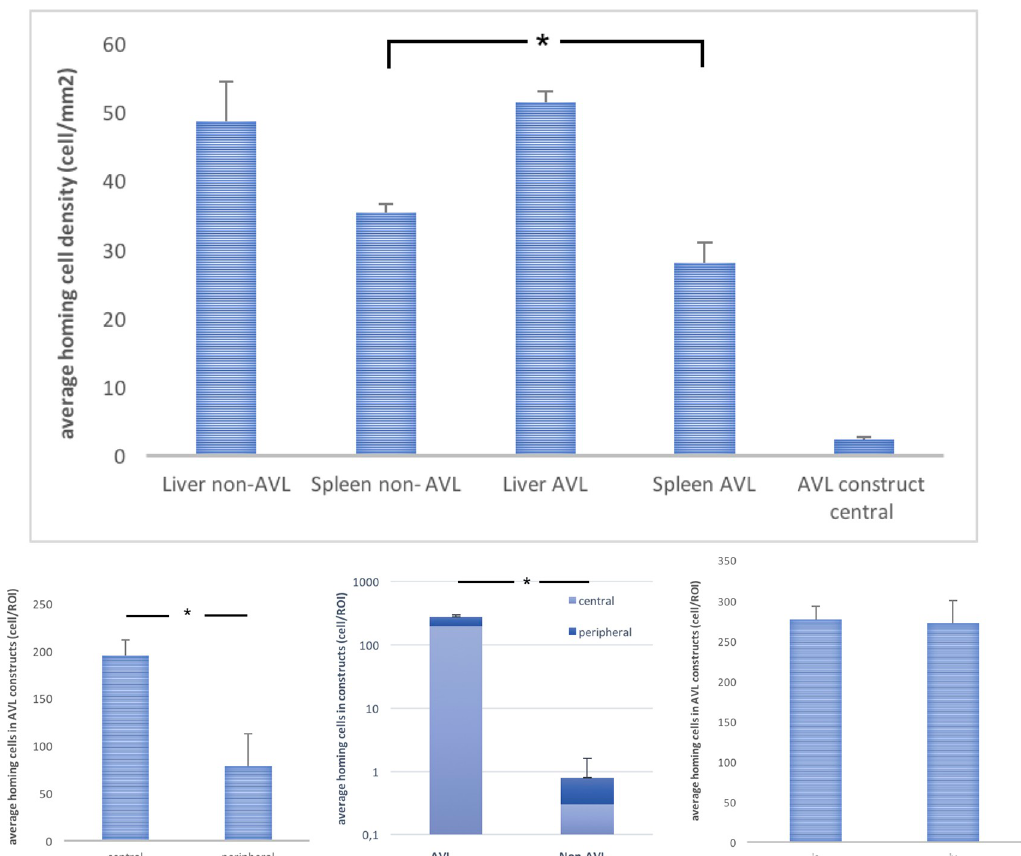
Fig 4. Histomorphometric analysis of cell engraftment in various tissues 48h after injection as detected by fluorescence microscopy, ( � ) indicates statistical significance.